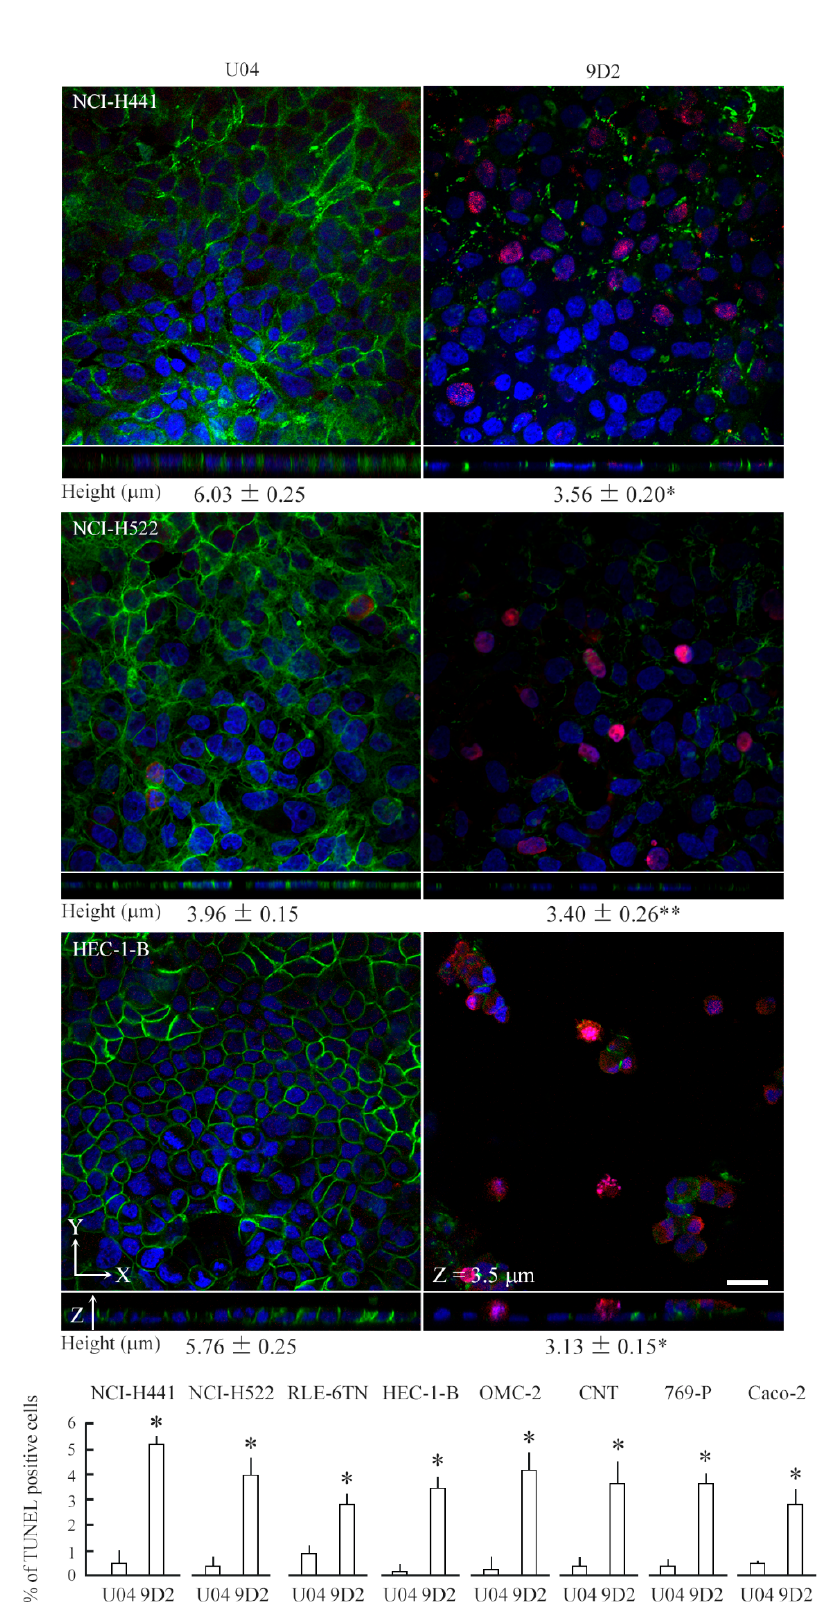
Figure 5. 9D2 induces apoptosis in crowded epithelial cells and decreases the cell height. Various epithelial cell lines were cultured on a semipermeable membrane in 12-well plates. When the cells reached 100% confluence, control IgY U04 or 9D2 was added at a concentration of 10 µg/mL. After 2 days, the cells were triple stained with CADM1 immunofluorescence (3E1 antibody; green), TUNEL method (red), and DAPI nuclear staining (blue). The means and standard deviations of TUNEL-